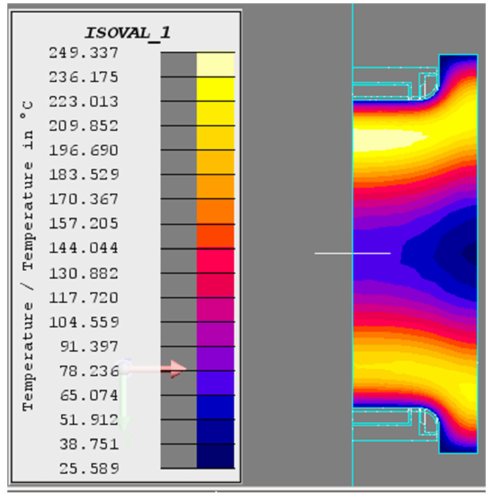
Figure 9. Temperature field of the crankshaft (T = 4 s).